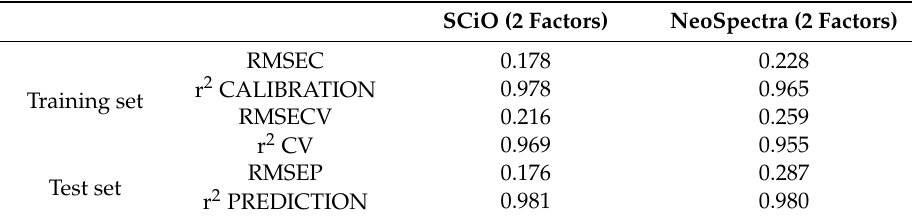
Table 3. PLS models for fat prediction with the training and test